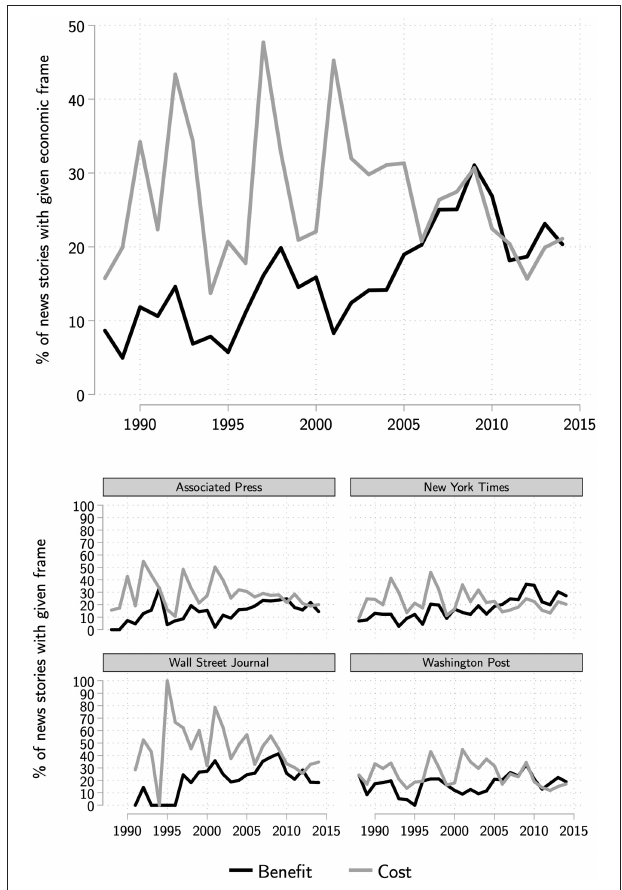
FIGURE 1 | Proportion of climate change news coverage with economic framing from 1988 to 2014 in our combined corpus (top panel) and by source (bottom panels).